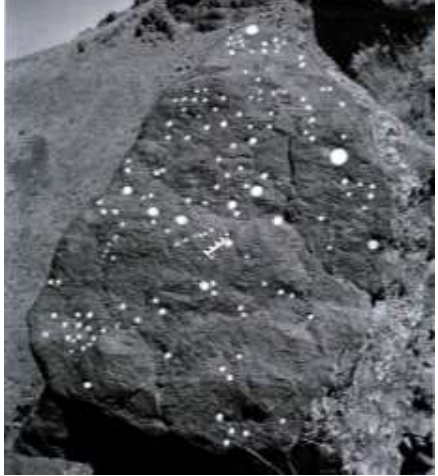
Figure 12. The cupules of Afrasiaw village, the order of these cupules in this boulder is thought to be deliberate. Some are engraved circle like and some in pairs or in